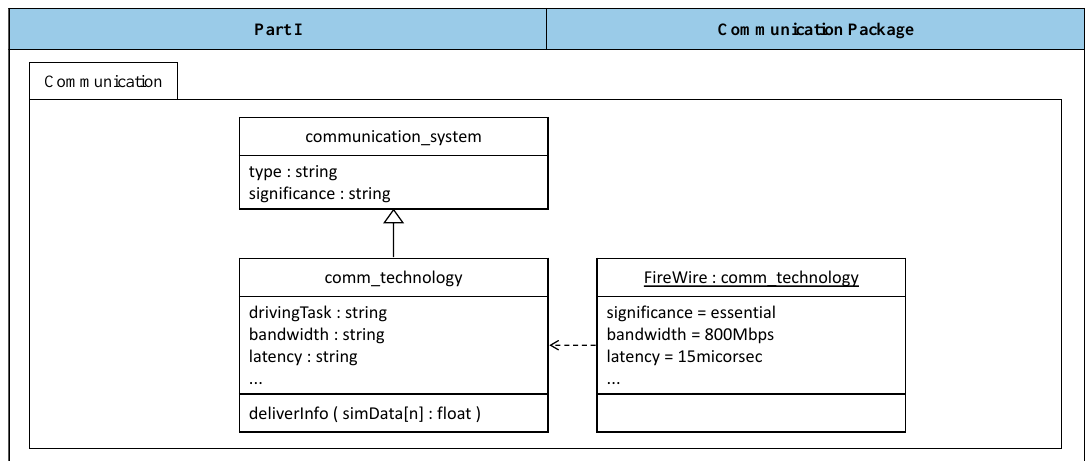
Figure 17. Specification/requirement radar charts of the selected system components. Analogously, the second section of the second part contains the specification/requirement radar chart of the selected communication technology. Figure 18 shows the two networked driving simulators of the second example application scenario. The HNI PC-based driving simulator is utilized as shown at the left side within Figure 18. It is the same simple driving simulator variant of the previous example application scenario. The Airmotion_ride driving simulator shown at the right side within Figure 18 has a pneumatic motion platform consisting of an inverted hexapod system that provides six DOF. A simple motion controller regulates the extension and contraction of six pneumatic elastic tubes based on the position and orientation of the simulated vehicle. Similar to the HNI PC-based driving simulator, the Airmotion_ride driving simulator has a 60-inch high-definition screen and a low-cost commercial wheel-transmission-pedals set. The Airmotion_ride driving simulator is operated by a software package developed with MATLAB/Simulink by the Heinz Nixdorf Institute. Similar to the platform of the first application scenario, the platform shown in Figure 18 follows the mixed-fidelity concept [38]. Specifically, two driving simulators of two different complexity grades and component fidelity levels share the same virtual environment to achieve a common goal.